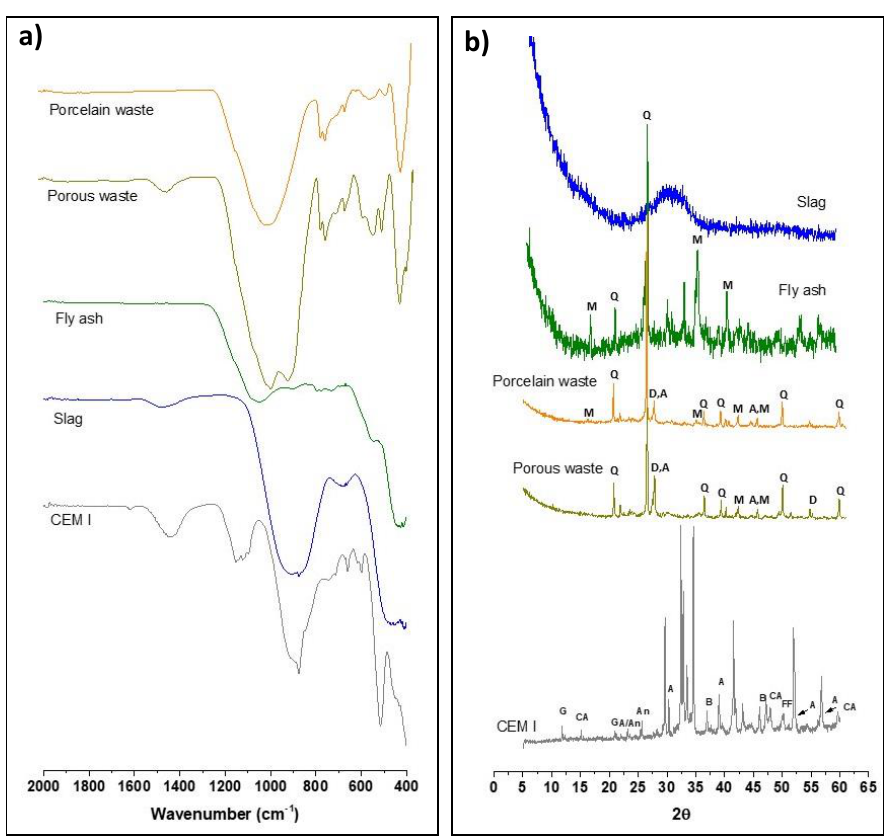
− 1 and ( b ) XRD di ff ractogram of Figure 1. ( a ) FTIR spectra region between 2000 and 400 cm −1 and ( b ) XRD diffractogram of different Figure 1. ( a ) FTIR spectra region between 2000 and 400 cm di ff erent materials used (Portland cement (CEM I), slag, fly ash, porous waste, and porcelain waste). The di ff ractogram corresponding to CEM I presents di ff erent crystalline phases (G = gypsum; CA = C 3 A; An = anhydre; A = C 3 S; B = C 2 S; FF = C 4 AF); the di ff ractogram corresponding to porous and